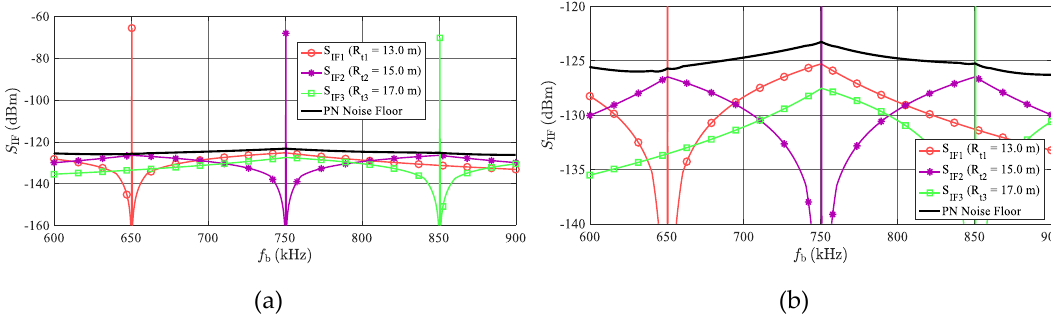
Figure 9. ( a ) MATLAB simulation of the power spectrum of received radar beat signals of three artificial targets at a single azimuth with a radar cross-sections (RCS) σ = 100 m 2 and distances of 13, 15 and 17 m (mutual critical distance equals 2 m). Applied noise bandwidth equals B = 12.5 kHz and all simulated targets share the same LO characterized by the power spectrum density (PSD) of its phase noise defined in Figure 7. The frequency-modulated continuous-wave (FMCW) radar parameters considered are defined in Section 6. ( b ) Detail of the approximately calculated −125 dBm phase noise floor.